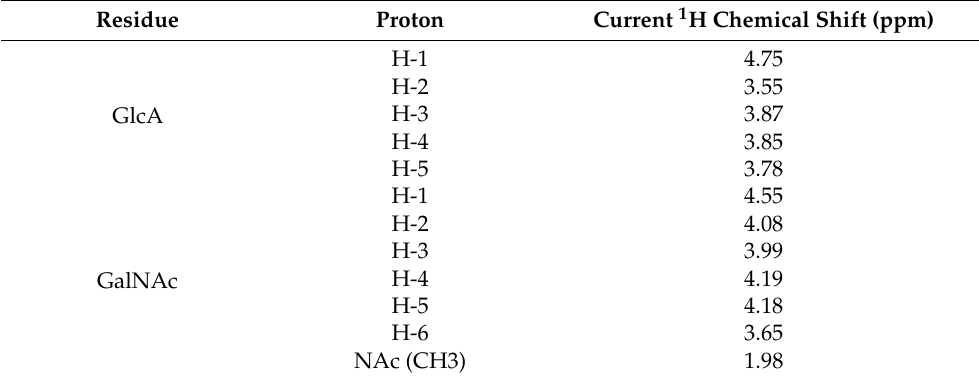
Table 5. 1 H NMR (600 MHz) chemical shift of purified jumbo squid